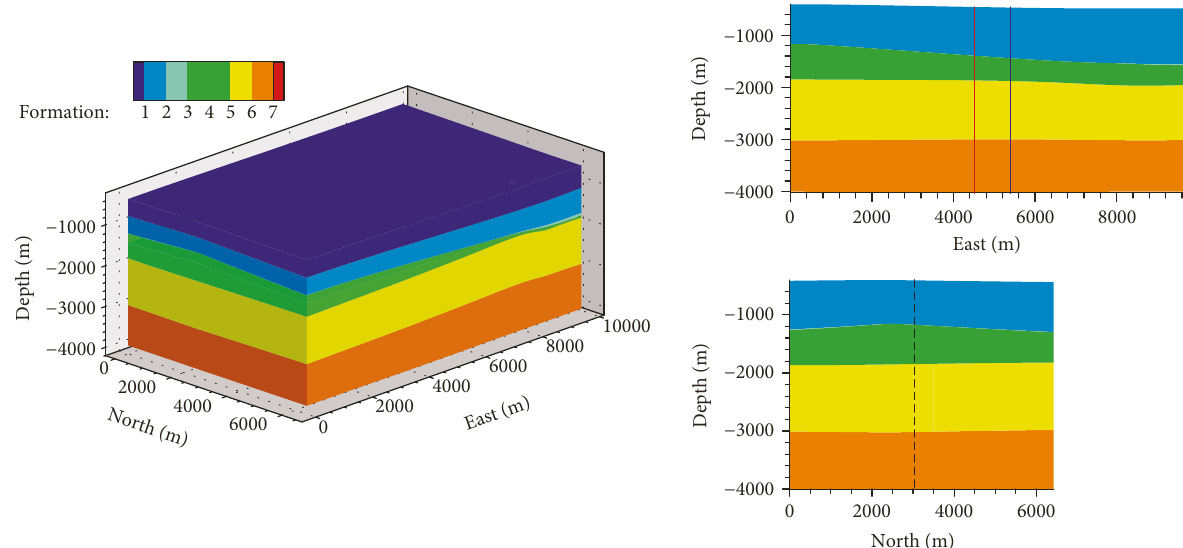
Figure 2: Lithology structure of the study area (rectangular area of the dotted line in Figure 1(c)) (formation 1: the Quaternary Formation, formation 2: the Mesozoic Formation, formation 3: the Neogene Formation, formation 4: the Ordovician formation, formation 5: the Cambrian Formation, formation 6: Neoproterozoic Formation, and formation 7: Wumishan